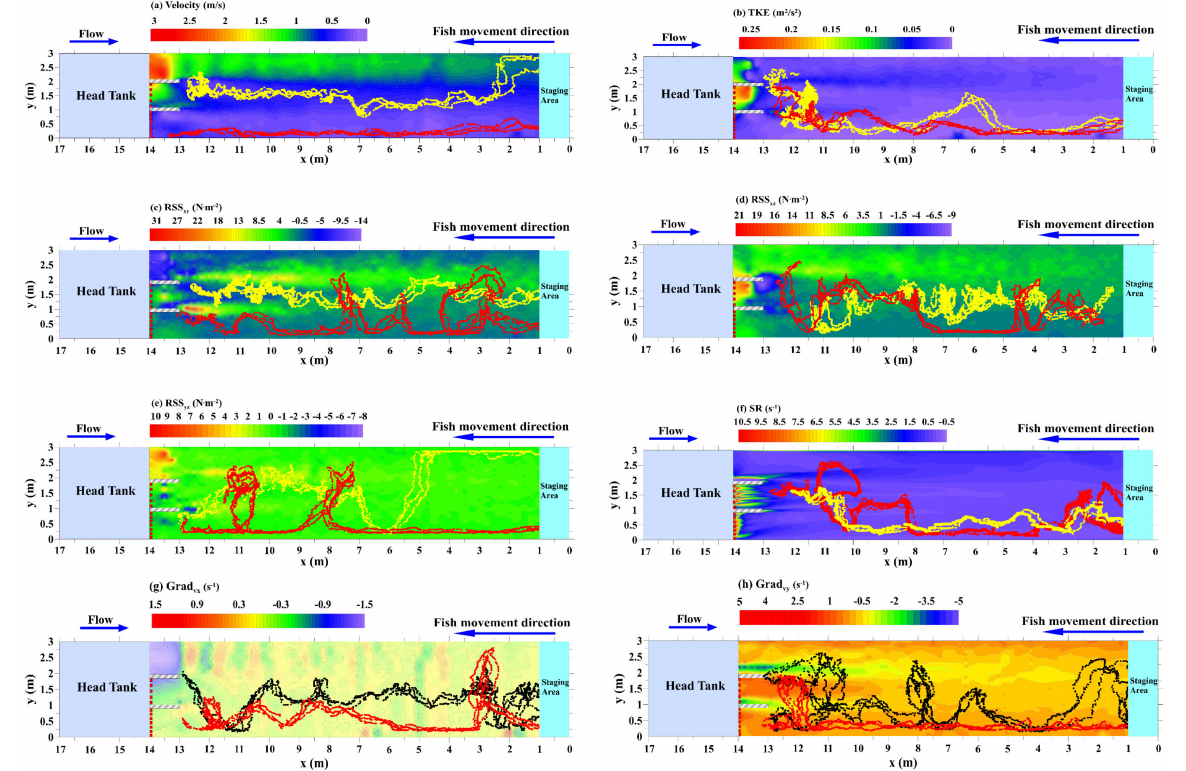
Figure 5. Diagrams of the typical swimming trajectories of S. prenanti schools superimposed on the distributions of different hydrodynamic parameters: ( a ) flow velocity (m/s); ( b ) turbulent kinetic energy (TKE, m 2 · s − 2 ); Reynolds shear stress in three planes: ( c ) RSS xy , ( d ) RSS xz , and ( e ) RSS yz , N . m − 2 ; ( f ) strain rate (SR, s − 1 ); and ( g ) velocity gradient along (Grad vx , s − 1 ) and ( h ) perpendicular to the direction of water flow (Grad vy , s − 1 ).